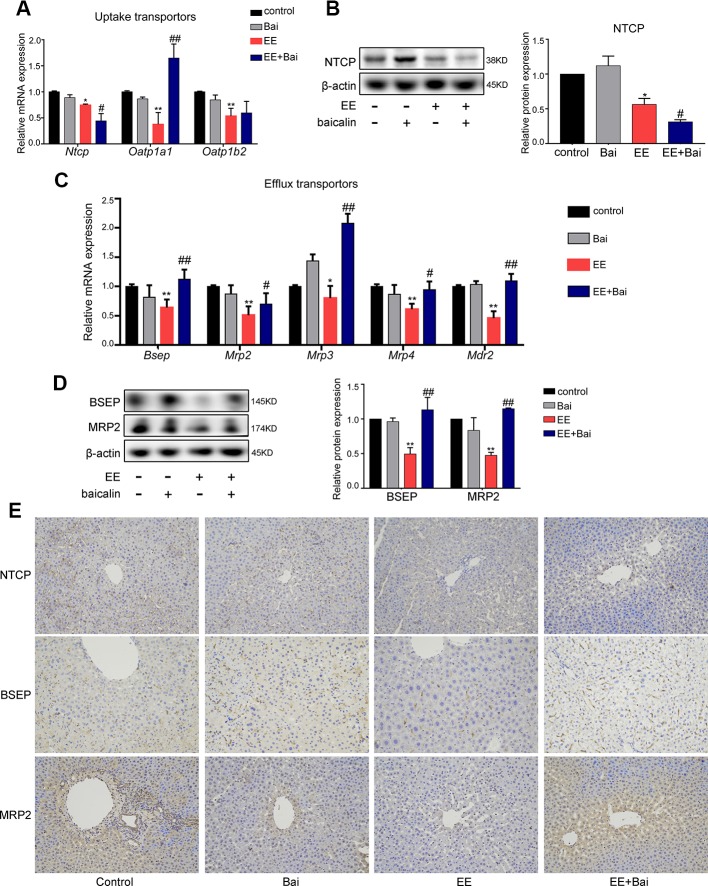
Baicalin promotes bile acid (BA) efflux and reduces BA influx in cholestatic rats. (A) The mRNA expression of BA uptake transporters, Ntcp, Oatp1a1, and Oatp1b2. (B) The protein level of NTCP. (C) The mRNA expression of BA efflux transporters, Bsep, Mrp2, Mrp3, Mrp4, and Mdr2. (D) The protein level of BSEP and MRP2. (E) Immunohistochemically staining for NTCP, BSEP, and MRP2 in rat liver. Data are presented as the mean ± SD (n = 6). *p < 0.05 and **p < 0.01 versus the control group, #p < 0.05 and ##p < 0.01 versus the EE group.